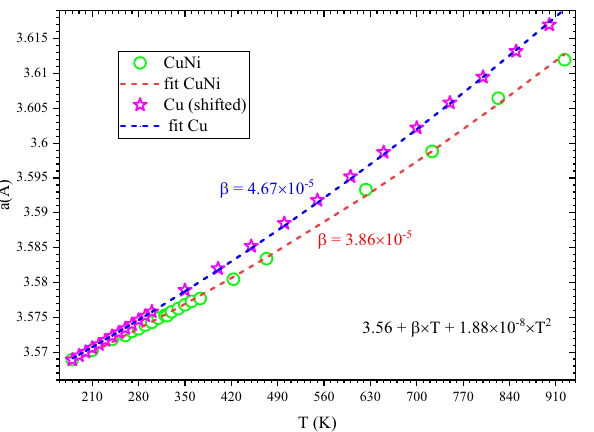
Figure 5. Comparison between temperature dependences of CuNi nanoparticles (circles) and bulk Cu, [( 41 ) stars] lattice parameters. For ease in comparison, copper lattice parameters are shifted down by a constant (0.0396 Å). Dashed lines are 2nd order polynomial fit to the data where the β values are indicated in the